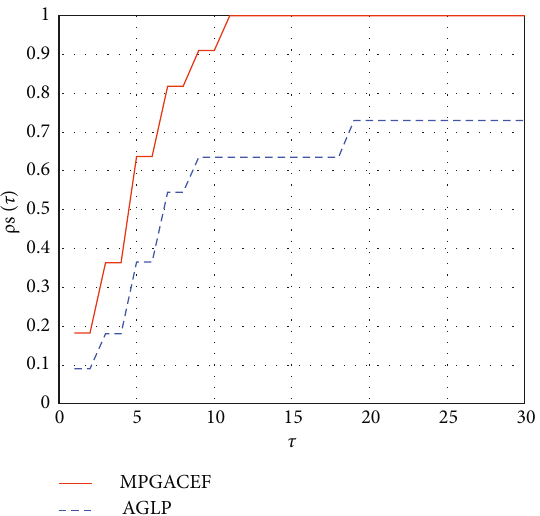
Figure 6: Performance of CPU Time for MPGACEF and AGLP under the condition of CVRP100.